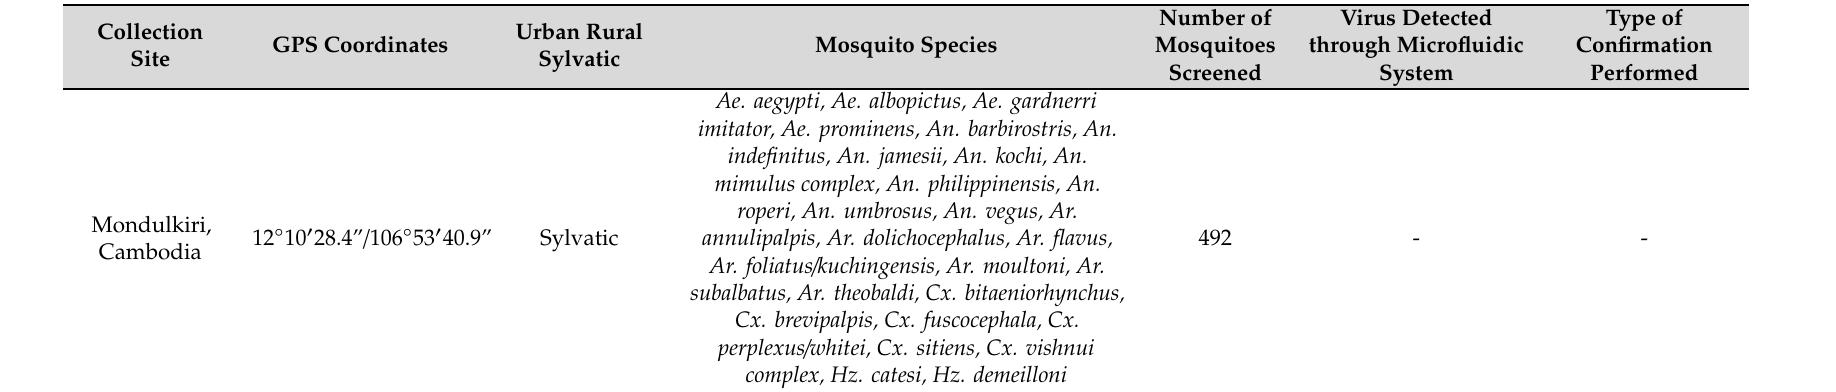
Table 2. Mosquito species, number of mosquitoes collected, and number of pools analyzed in